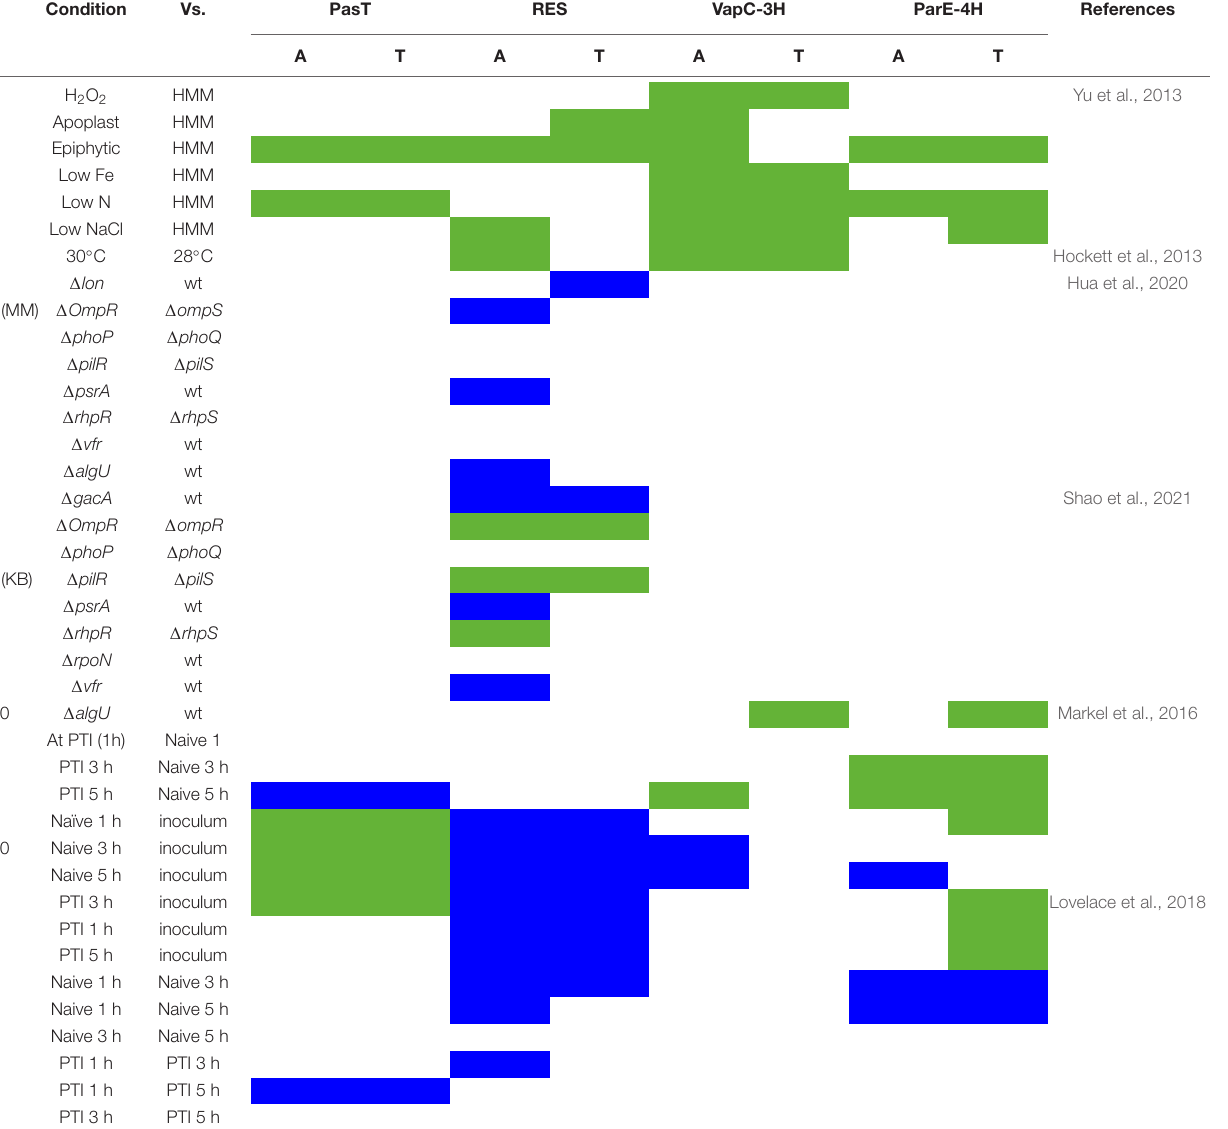
TABLE 2 | Reported expression patterns of TA system genes in three model strains B728a, 1448A, DC3000. Strain Condition Vs. PasT RES